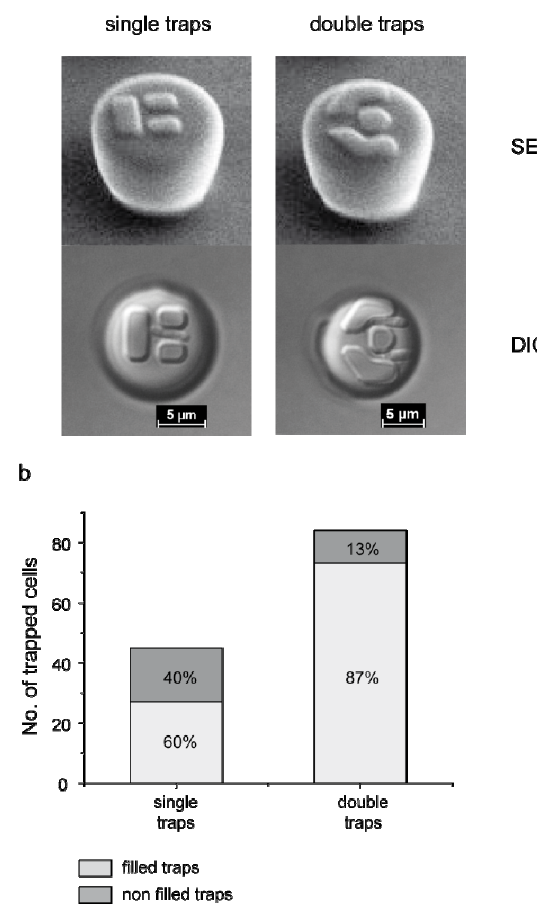
immobilization and cultivation of E. coli . ( b ) Comparison of the number of trapped cells in single and double cell traps. After flushing the device with the cell suspension for a couple of seconds, 60% of the single traps and 87% of double traps were